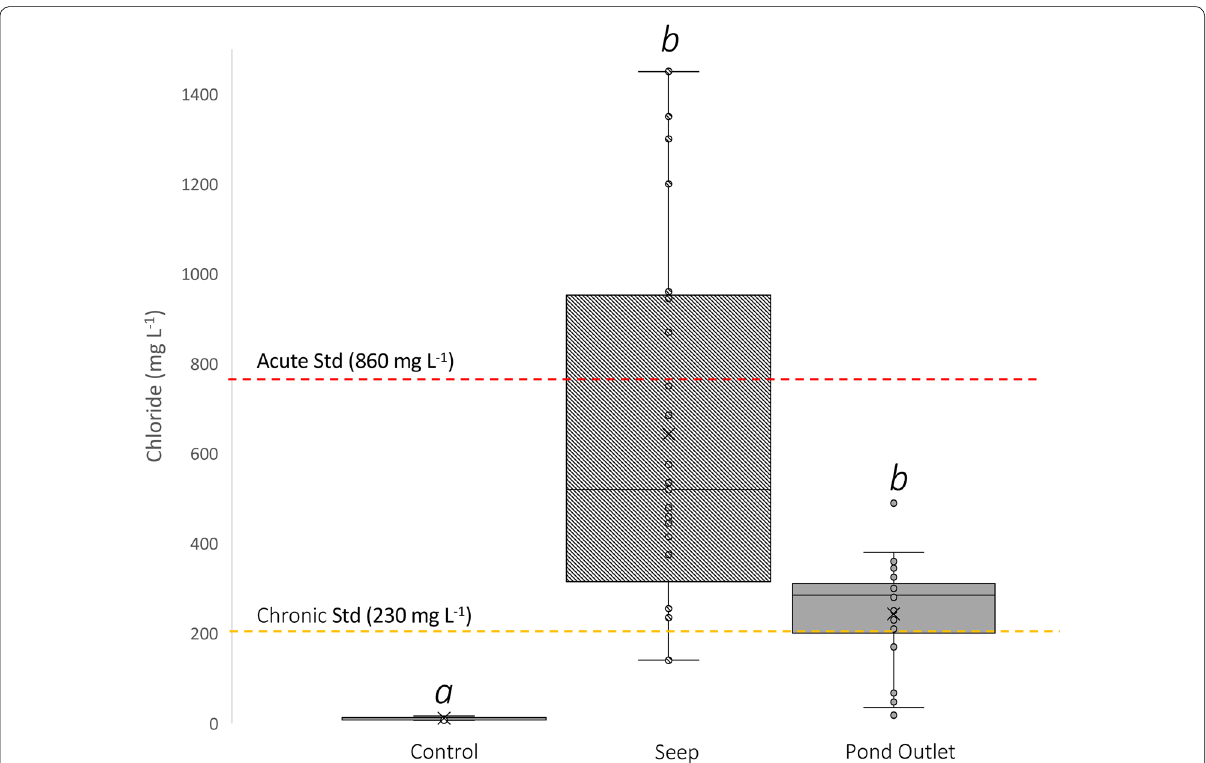
Fig. 3 Chloride concentrations for water grab samples at the “Control,” “Seep,” and “Pond Outlet” sites. Difference in letters denotes statistical significance at α 0.05. The “LaPlatte” monitoring point data is not included in this graph due to the nature of the sample type (taken in a river) ≤ differing significantly from the other sampling